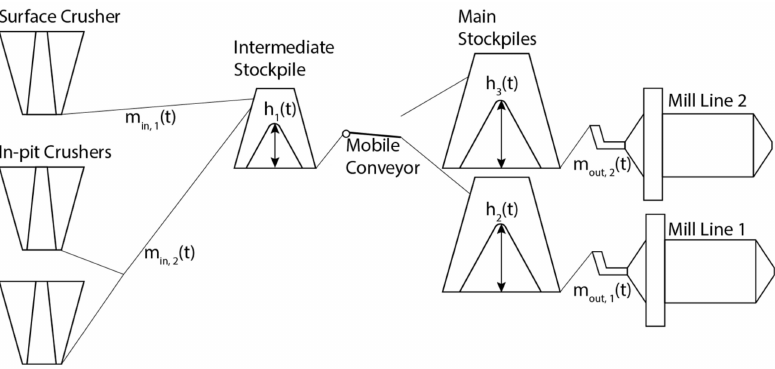
Figure 5. Layout of the ore transportation system between the crushers and the primary